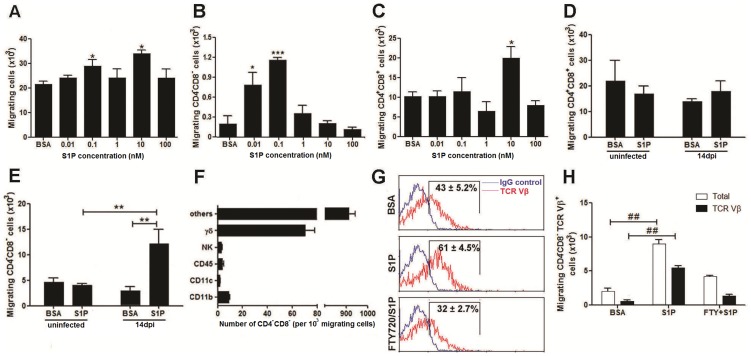
S1P promotes migration of immature thymocytes from T. cruzi-infected mice.Migratory responses of thymocytes isolated from infected and normal mice were assessed in transwell chambers as described in Materials and Methods. S1P was added to the lower chamber at the indicated concentrations. (A) Total thymocytes obtained from infected mice were assayed at 0.01, 0.1, 1, 10 and 100 nM S1P. Our data show two peaks of migration, in 0.1 and 10 nM S1P. Phenotype characterization of migrating cells by FACS analysis showed that the higher migratory response of CD4−CD8− thymocyte subset occurs towards 0.1 nM S1P (panel B), whereas CD4+CD8+ thymocyte subset migrates mainly through 10 nM stimuli of the agonist (C). Data show mean ± SE in four independent experiments using three pooled thymuses. Differences between S1P and BSA groups are significant # (p<0.05) and ### (p<0.001). The migratory responses of FACS isolated CD4+CD8+ (D) and CD4−CD8− (E) T cells from uninfected and infected mice were assessed in transwell chambers towards 0.1 nM S1P stimulus. Our data show an increased S1P-driven migration of CD4−CD8− thymocytes obtained from infected mice present as compared to non-infected controls. Data show mean ± SE in three independent experiments using five pooled thymuses. Differences between uninfected and infected groups are significant ** (p<0.01). Differences between S1P and BSA groups are significant ## (p<0.01). (F) Migrating CD4−CD8− cells were characterized by flow cytometry analysis according to the expression of the following phenotypic markers: CD11b (macrophages), CD11c (dendritic cells), CD45 (B cells), CD161 (NK T cells) and TCRδ; Intrathymic CD4−CD8− T cell progenitors (others) were characterized by the absence in the expression of these markers. Data show means ± SE per 103 cells characterized in two independent experiments. (G) The determination of the S1PR1-dependent migration of CD4−CD8− T cells isolated from infected mice was assessed upon treatment of the cells with the functional antagonist of S1P receptors FTY720 (102 nM) during 30 min at 37°C previously to migration in transwell chambers towards the 0.1 nM S1P stimulus. A representative FACS profile is shown from one of three independent experiments. The ratio of CD4−CD8−TCR Vβ+ cells was obtained and the background staining eliminated using the isotype control antibody. (H) We show an increase in the absolute numbers of total and TCRVβ+CD4−CD8− T cell migration toward the S1P stimulus. This is prevented when the cells were previously incubated with FTY720. Data show mean ± SE in two independent experiments using five pooled thymuses. Differences between S1P and BSA groups are significant ## (p<0.01).